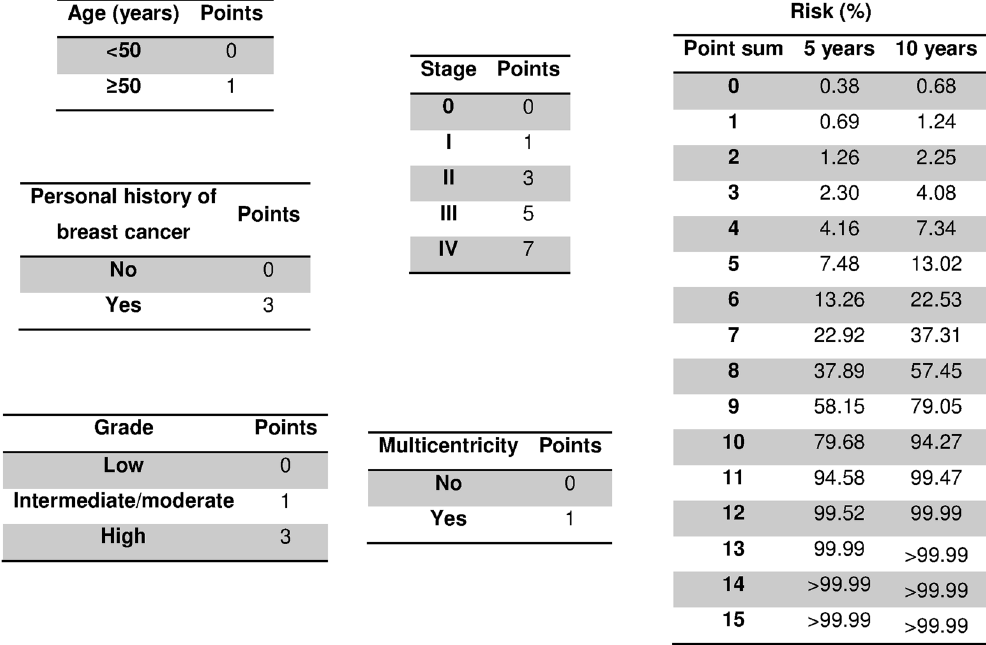
Figure 1. Scoring system to predict breast cancer mortality.